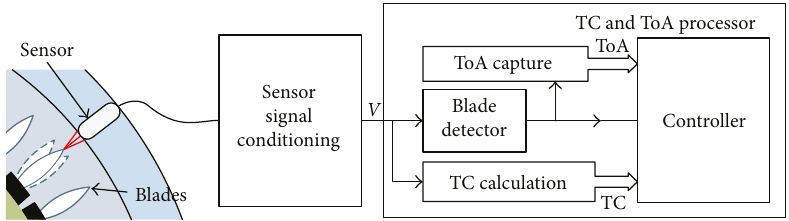
Figure 1: Block diagram of the architecture to extract ToA and TC